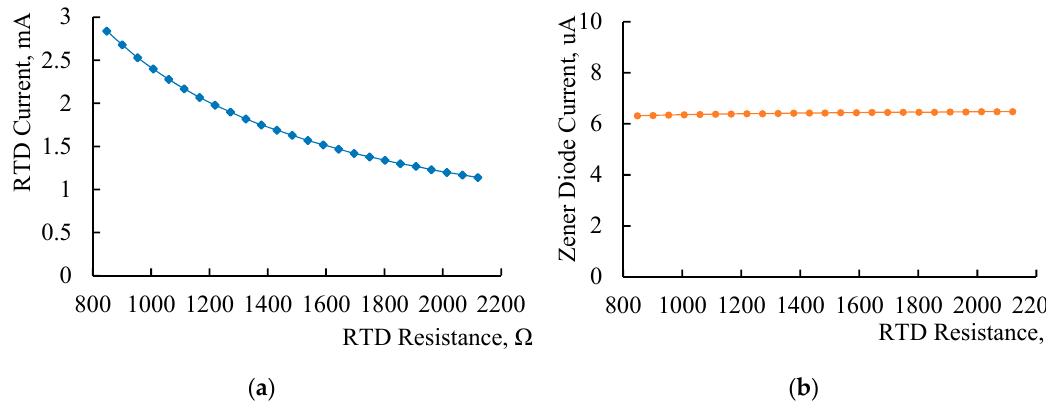
Figure 2. ( a ) Current through RTD changes over its resistance under CCS supply; ( b ) current through